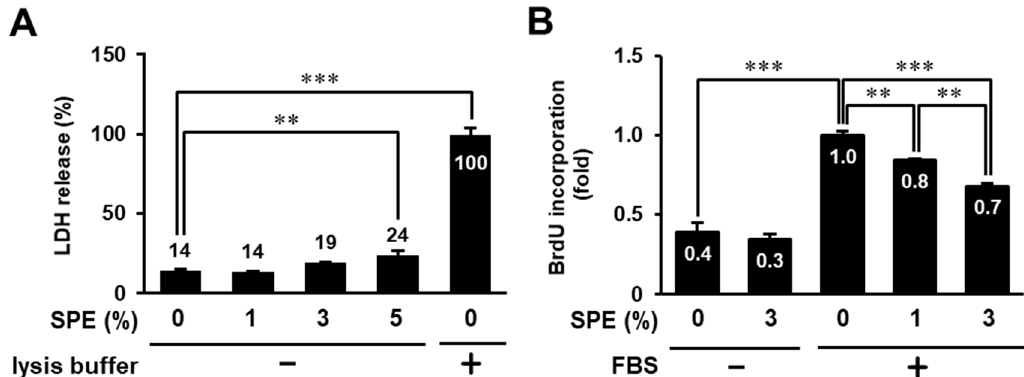
Figure 1. Cytotoxicity and antiproliferation activity of Citrus sudachi peel extract (SPE) on keratinocytes. (A) HaCaT cells were treated with 0%, 1%, 3%, and 5% SPE for 24 h and subsequently subjected to the lactate dehydrogenase (LDH) release assay. The lysis buffer was added as a positive control. (B) Serum-starved HaCaT cells were pretreated with 0%, 1%, and 3% SPE for 1 h, and then incubated in the presence or absence of 3% fetal bovine serum (FBS). After 24 h, the cells were subjected to a 5-bromo-2 ′ -deoxyuridine (BrdU) incorporation assay. The data were expressed as the mean ± standard error (SE) derived from at least three independent experiments, and statistical analysis was performed by ANOVA with Bonferroni’s multiple comparisons test; *** p < 0.001, ** p < 0.01.